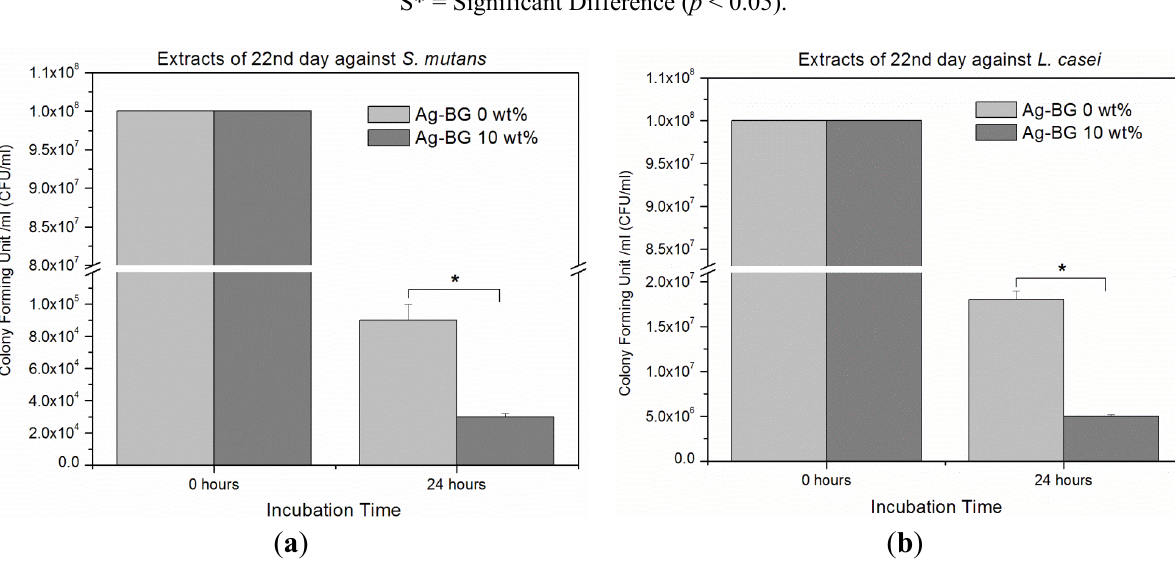
Figure 5. Antibacterial activity of the extracts of control and Ag-BGCOMP samples, after 22 days of immersion in PBS, shows significant bacteria growth inhibition against ( a ) S. mutans and ( b ) L. casei (error bars = ±SD; n = 3, * p <